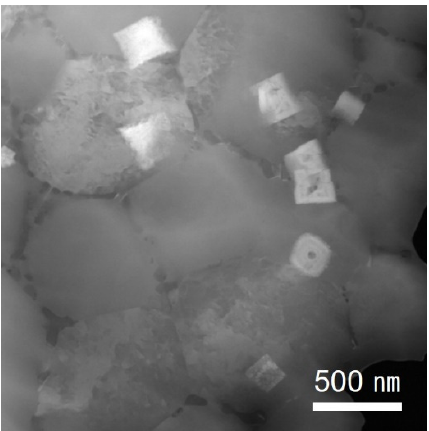
Figure 5. Low-magnification BF-TEM image of the fine-grain region.